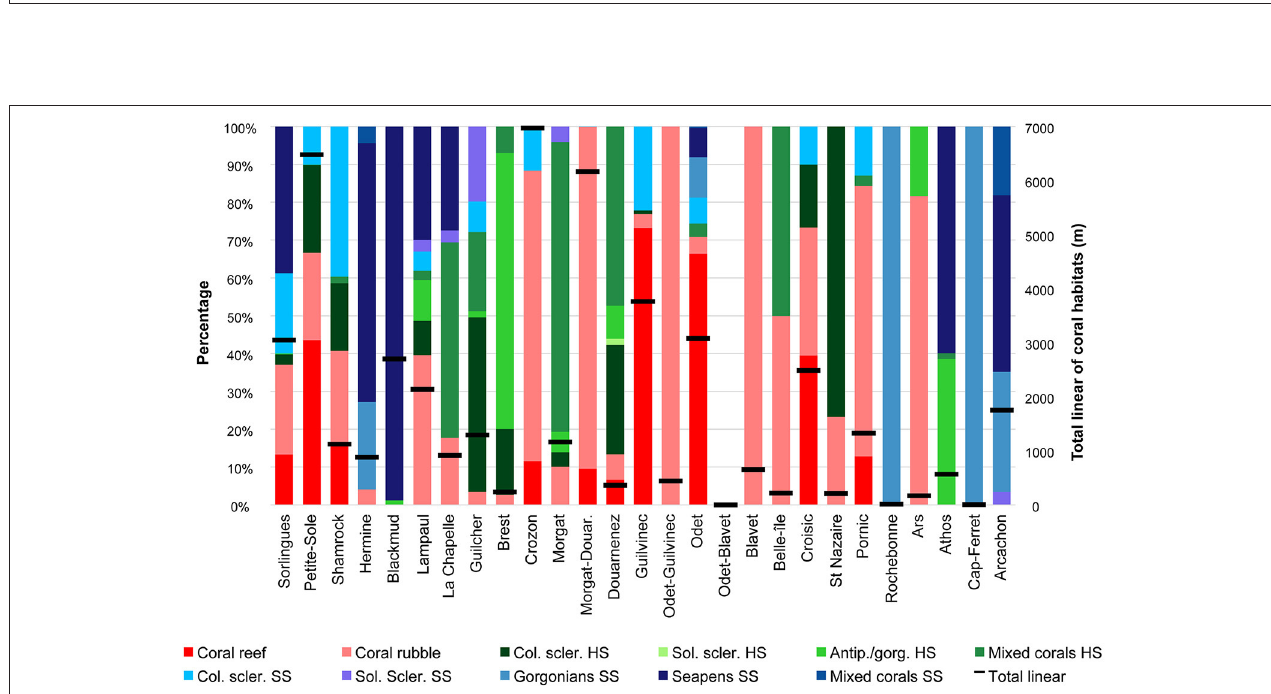
FIGURE 6 | The distribution of the coral habitats in the submarine canyons of the Bay of Biscay. The stacked barplots show the proportion of each coral habitat (primary y-axis) in the canyons (x-axis) of the Bay of Biscay taken from the total linear of coral habitats within that canyon that is indicated by the black lines (secondary y-axis). The canyons are arranged from the most northern canyon (Sorlingues; on the left of the x-axis) to the most southern canyon (Arcachon; on the right of the x-axis) that are investigated in this study. Col. scler, Colonial scleractinians; Sol. scler, Solitary scleractinians; Antip./gorg., Antipatharians/gorgonians.